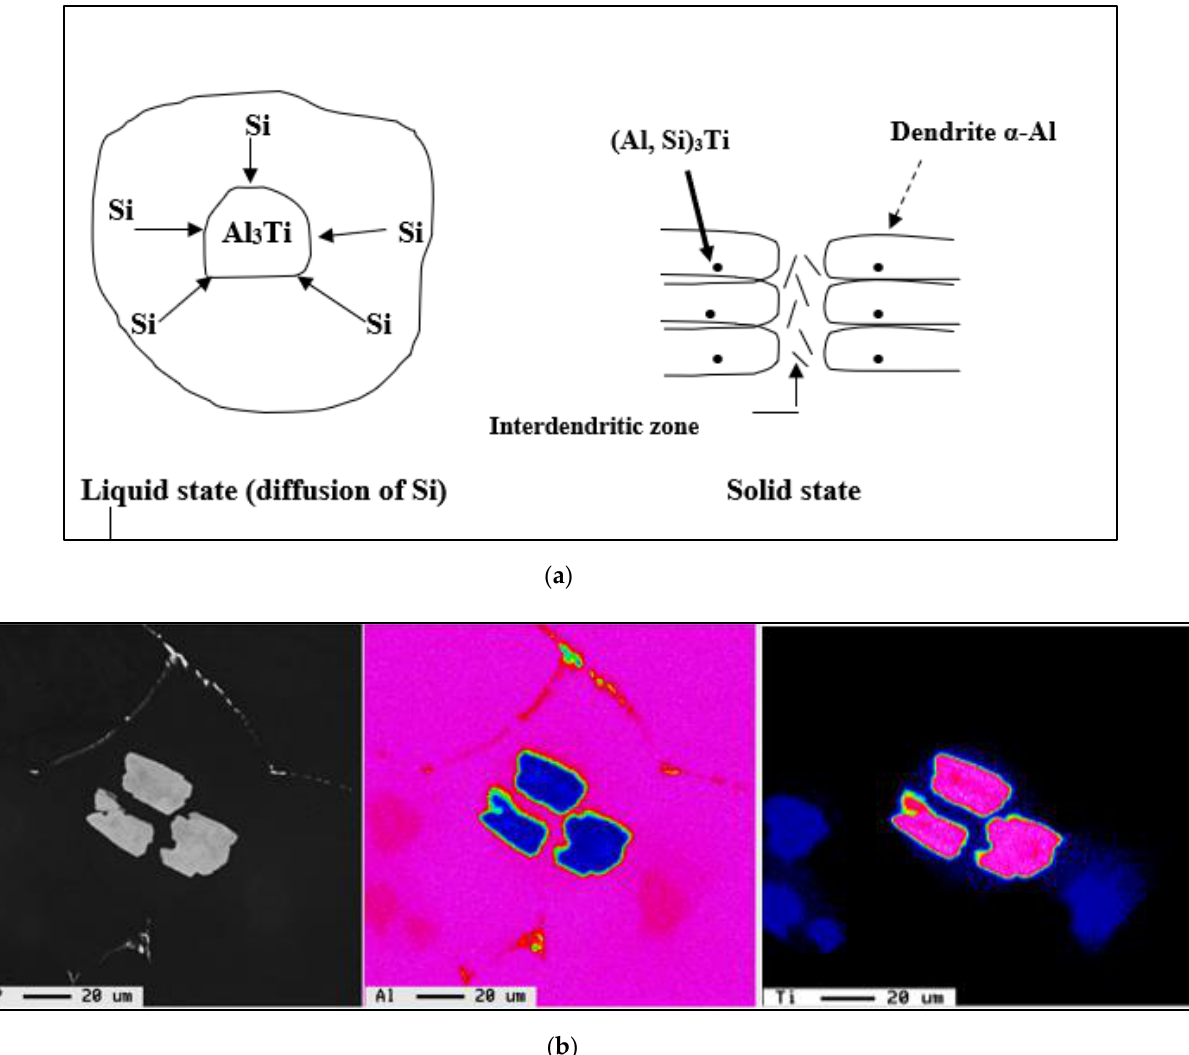
Figure 9. ( a ) Conversion of Al 3 Ti phase to (Al,Si) 3 Ti phase. This process is termed poisoning. The thick arrow points to precipitation of (Al,Si) 3 Ti particles within the α -Al dendritic network indicated by the broken arrow. ( b ) Left to right: Backscattered image showing precipitation of Al 3 Ti phase particles within the α -Al dendritic network, and corresponding X-ray images of Al and Ti.